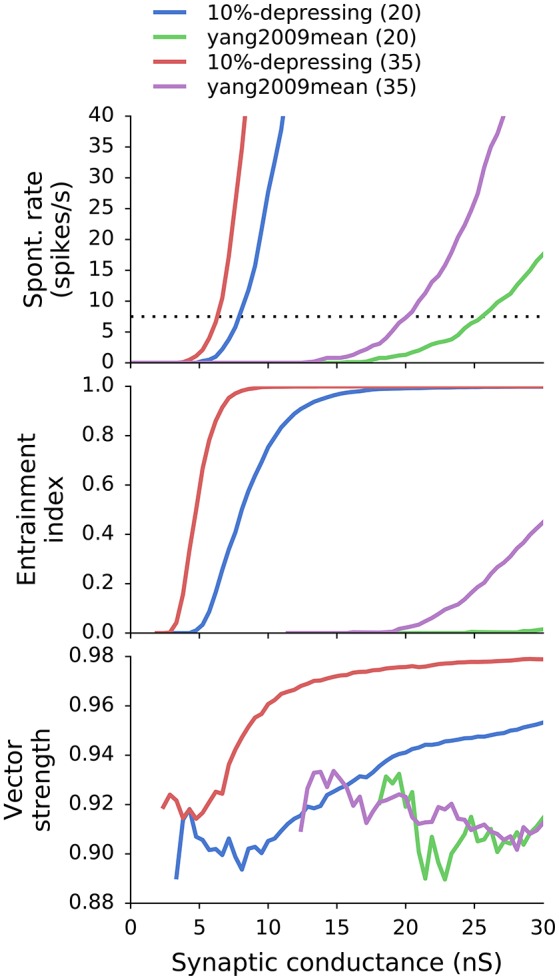
SR, EI, and VS as a function of synaptic weight for a combination of two synapse models (10%-depressing and yang2009mean) and two different number of ANF inputs (20 and 35). SR and EI increase with increasing synaptic weight. VS also increases with synaptic weight for 10%-depressing synapses, but does not increase for synapses tuned to Yang and Xu-Friedman (2009). The thin dotted black line marks the desired SR of 7.5 spikes/s (Spirou et al., 1990).